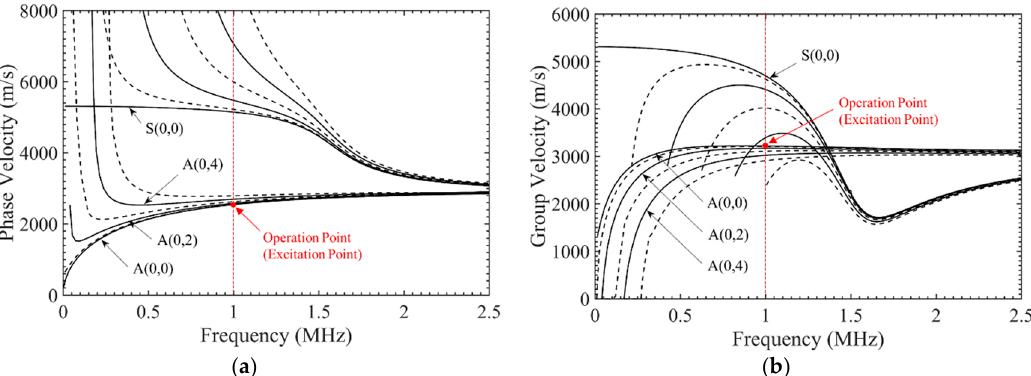
Figure 2. Dispersion curves of Lamb waves in a SS304 plate with 1.5 mm thickness and 15 mm width: ( a ) phase velocity, ( b ) group velocity; SS304 plate properties: density ρ = 7800 kg / m 3 , longitudinal wave velocity C L = 5800 m / s and shear wave velocity C S = 3160 m / s; solid line: even order of width mode (symmetric width mode); dashed line: odd order of width mode (anti-symmetric width mode).